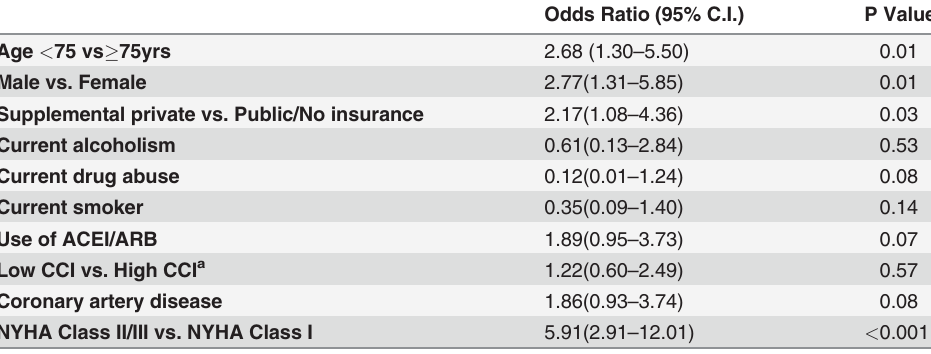
Table 4. Factors Independently Associated with ICD